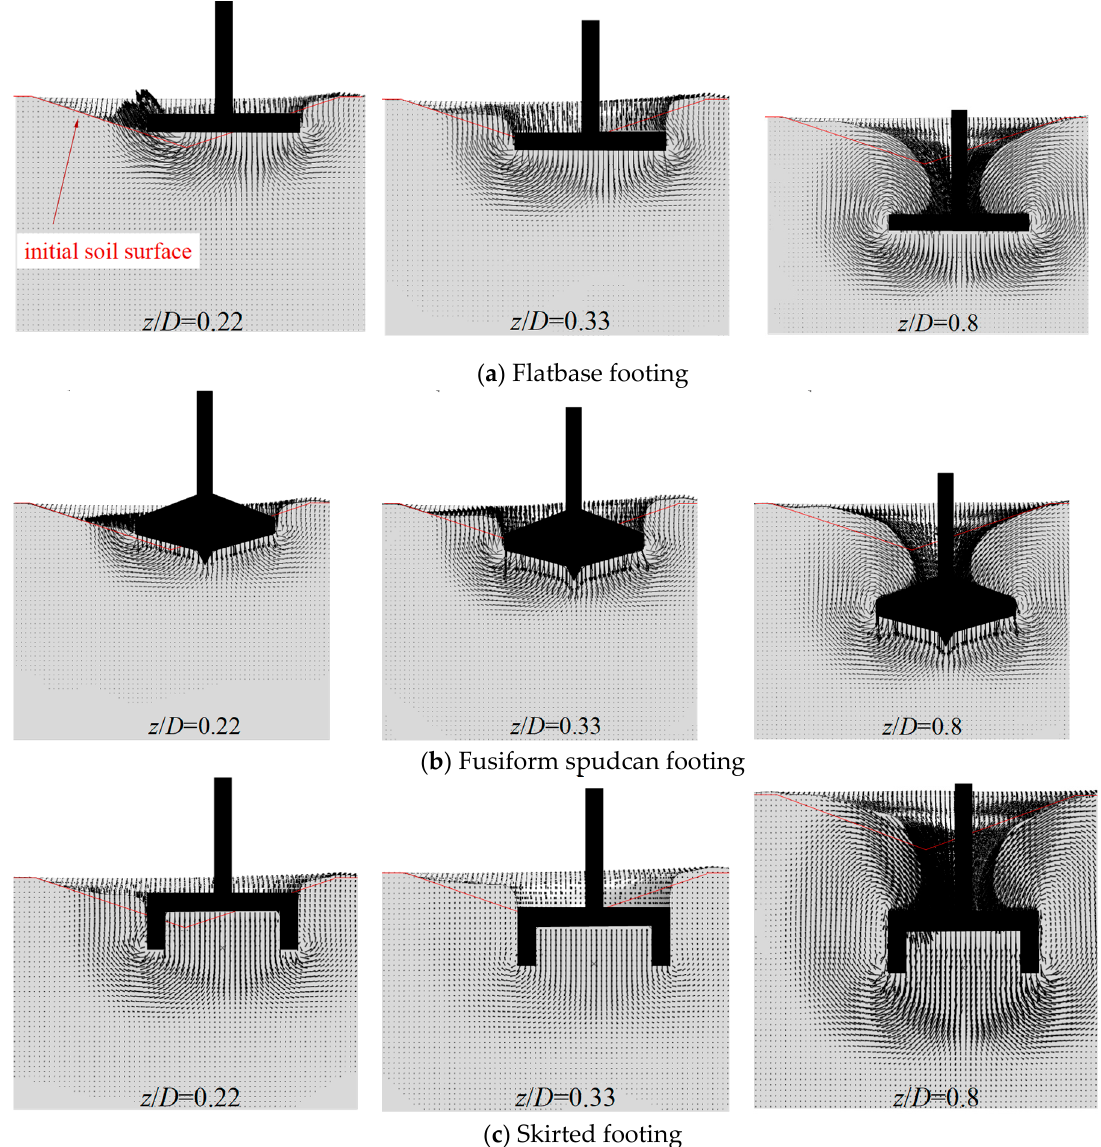
Figure 18. The soil flow mechanism for different footings (TB-2 D -0.25 D ).